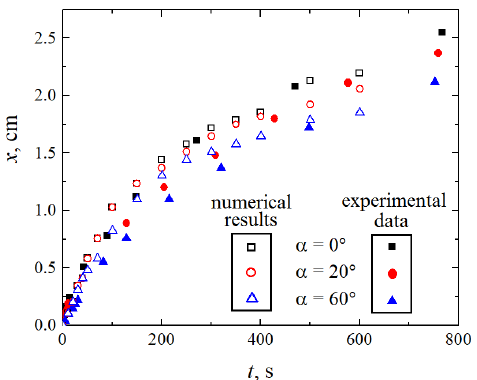
Figure 16. Dependence of the position of the wavefront on time for three values of the angle of inclination α = 0 ◦ (indicated by the black squares), α = 20 ◦ (red circles), α = 60 ◦ (blue triangles). The filled and unfilled symbols correspond to the experimental data and the results of numerical simulations,